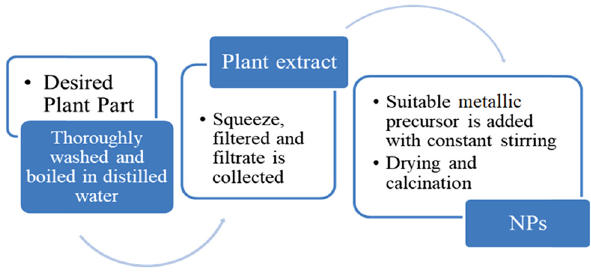
Figure 2: Flow chart representation of plant - mediated NP synthesis.